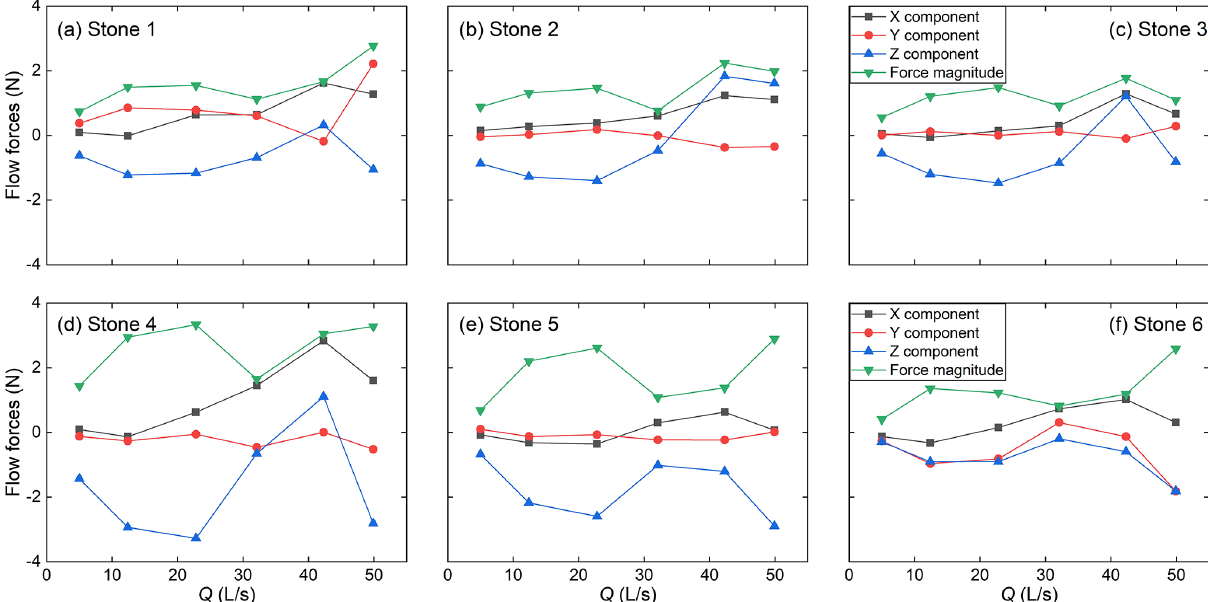
Figure 11. Variation of fluid force components and magnitude of resultant flow force acting on step stones with flow rate. Stone 4 is the keystone. Stone numbers are consistent with those in Figs. 9 and 10. The upper limit of the sampling volumes for flow force calculation is higher than the water surface, while the lower limit is set at 3cm lower than the keystone